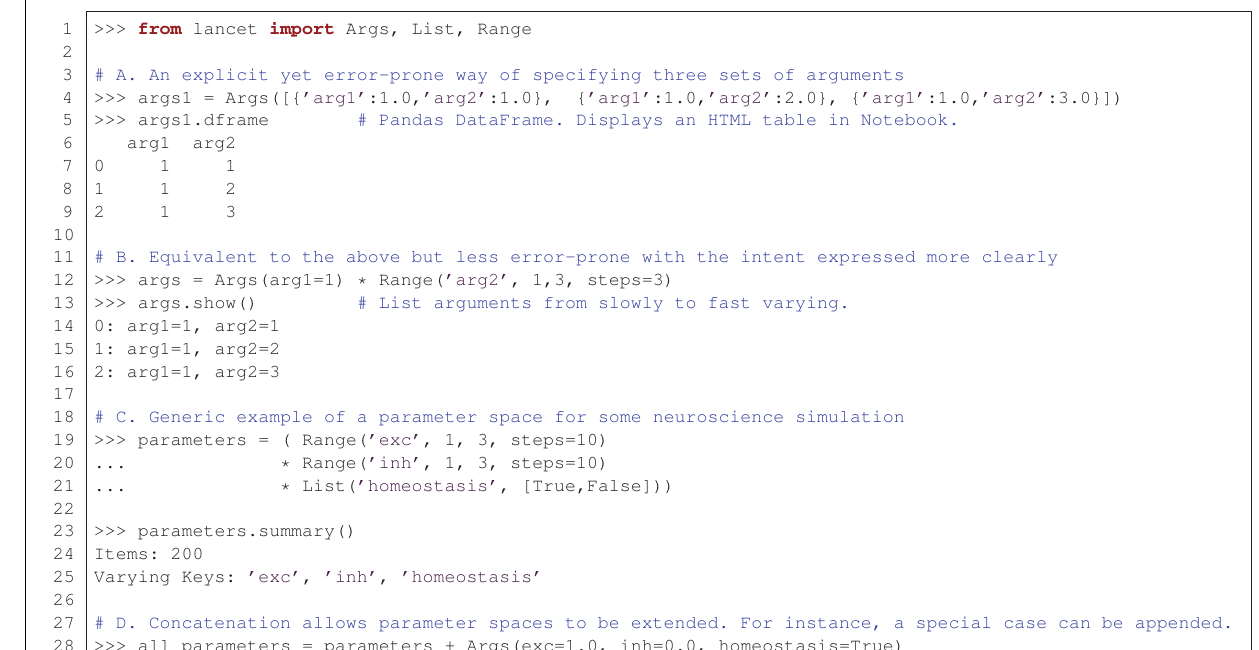
neural simulator. This parameter space covers a range of excitation and inhibition strengths, while toggling a homeostatic mechanism. (D) The concatenation operator allows arguments specified by Arguments objects to be sequenced, allowing special cases to be incrementally appended to a parameter